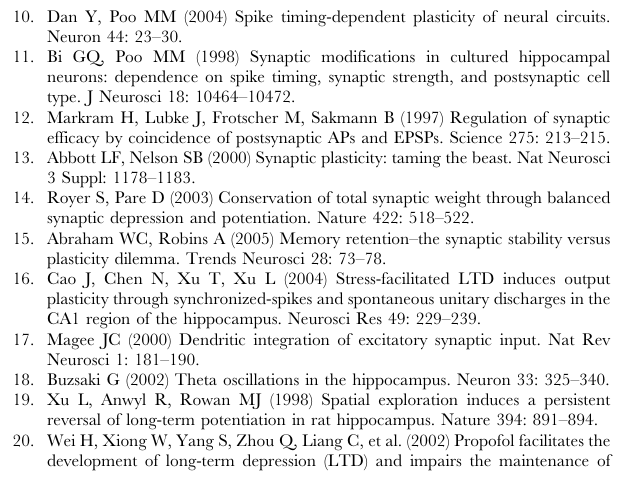
Figure S3 Pharmacological tools rapidly switch the distribution